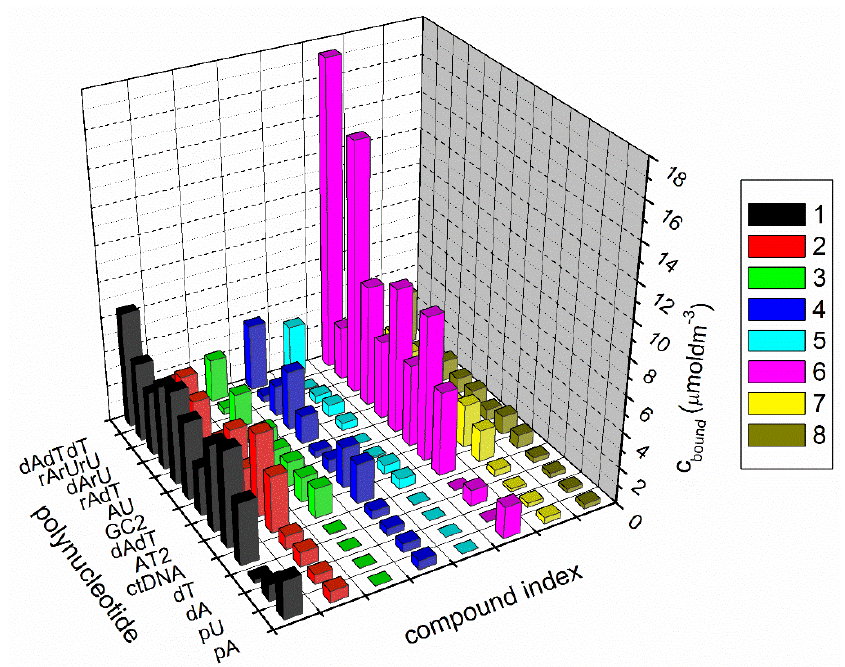
Figure 2. Summary of competition dialysis results with eight compounds binding to 13 nucleic acid structures and sequences (c bound = concentration of ligand bound to each nucleic acid in µ M); sodium cacodylate buffer, I = 0.05 mol dm − 3 , pH = 7, and +1 mM EDTA.